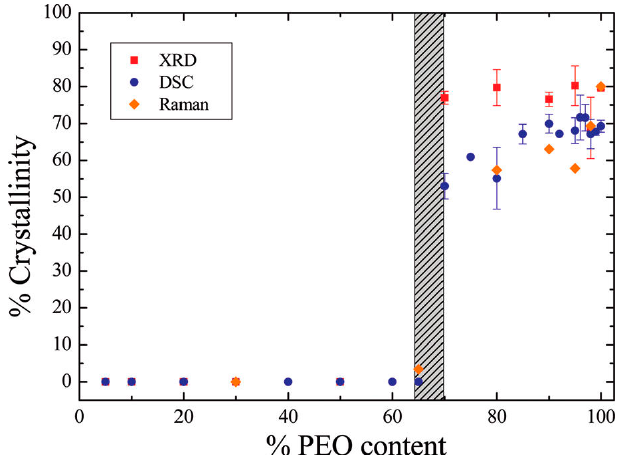
Figure 3. Degree of crystallinity of poly(ethylene oxide) (PEO)/Na + –MMT hybrids at 90 °C, plotted as a function of PEO weight %, obtained from the analysis of X-ray diffraction (XRD) ( filled squares ), differential scanning calorimetry (DSC) ( filled circles ), and Raman spectroscopy ( filled diamonds ) data. Reproduced with permission from Chrissopoulou et al. [62]. Copyright 2011, American Chemical Society.